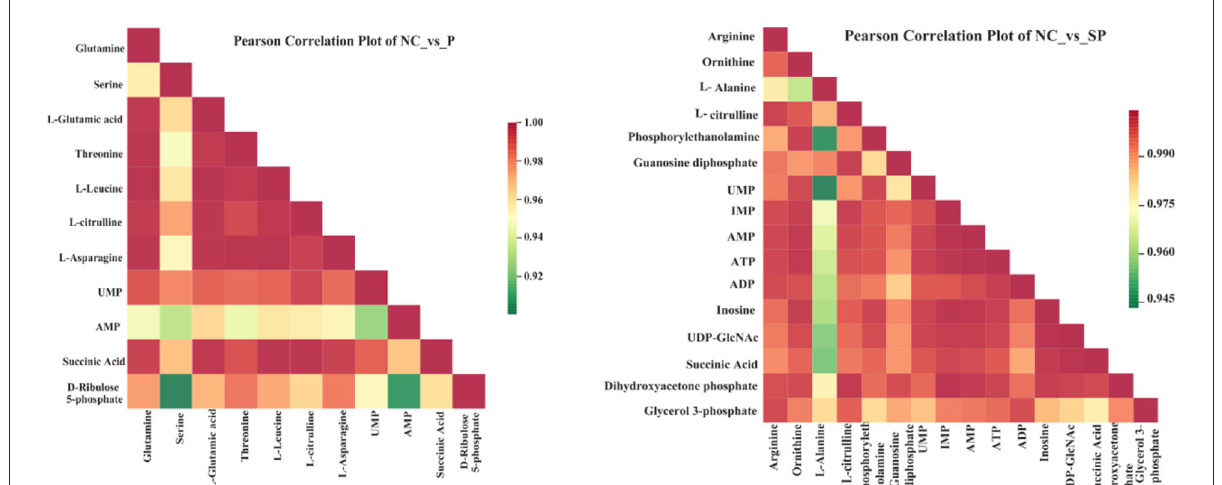
FIGURE6 Cluster heat map of differential metabolites.